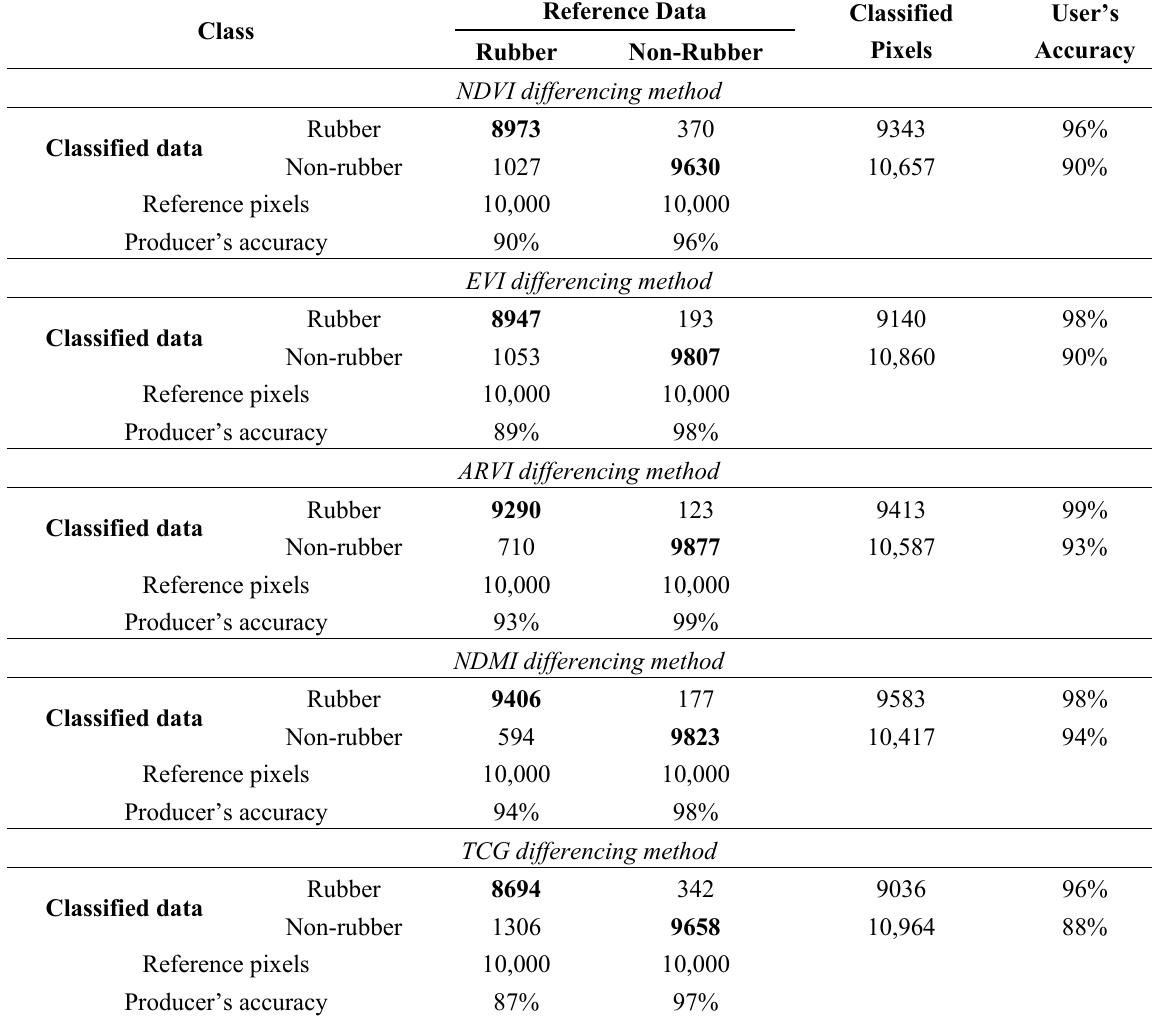
Table 1. Error matrices (pixel counts) for five vegetation index differencing methods. Non-rubber includes forest, cropland, built-up land, water body and other land cover